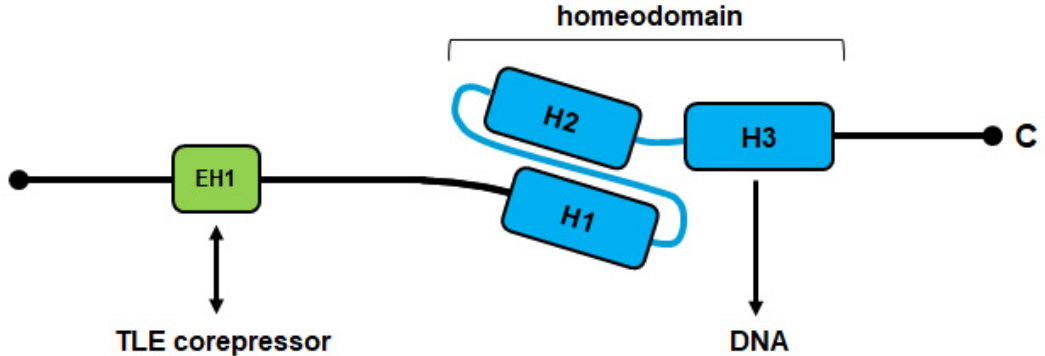
Figure 2. Schematic structure of NKL homeodomain proteins. N: N-terminal end; C: C-terminal end; EH1: conserved engrailed homology domain consisting of about 8 amino acid residues (shown in green); the conserved homeodomain consists of 60 amino acid residues which generate three helices (H1-3) and is shown in blue; the N- and C-terminal parts show no sequence conservation. The EH1 domain and the homeodomain interact with particular components of the gene regulatory machinery including corepressors of the TLE family and specific DNA sequences, respectively.